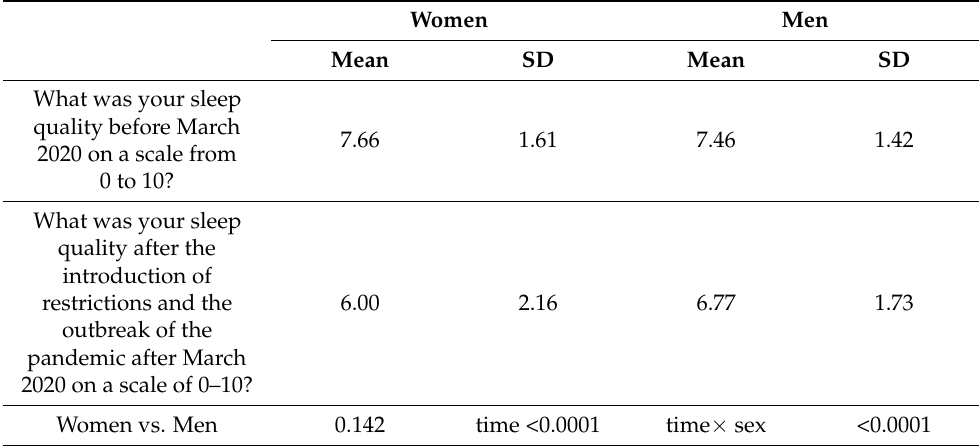
Table 2. Sleep quality before and during the pandemic.